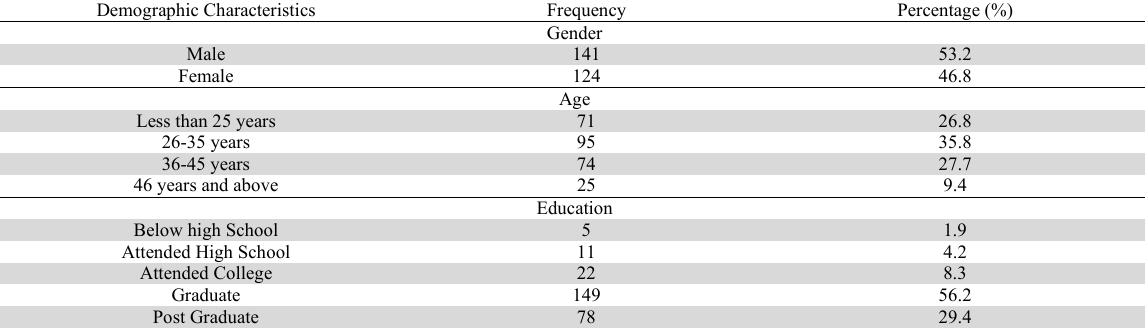
Demographic profile of the